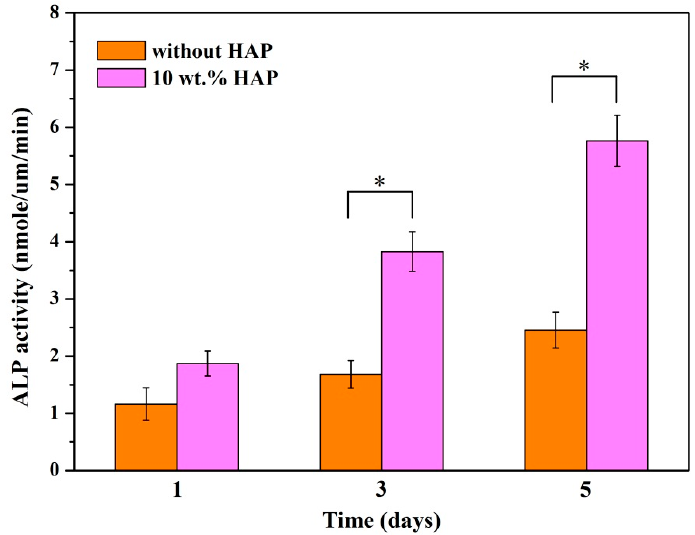
Figure 11. Alkaline phosphatase (ALP) activity of MG63 cells cultured on PEEK/PGA scaffolds and PEEK/PGA-10 wt % HAP scaffolds at various time points (* p < 0.05).